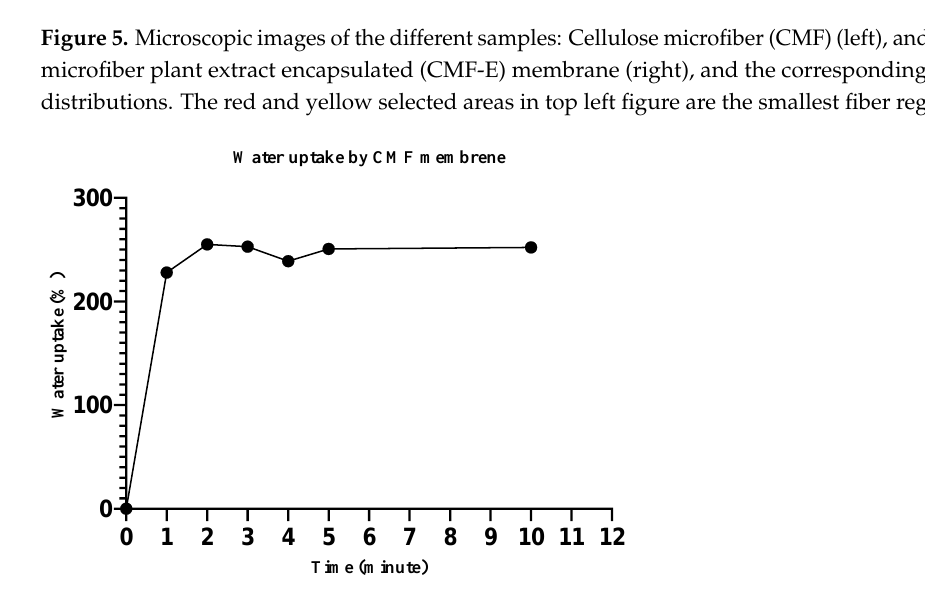
Figure 6. Water uptake efficiency by the cellulose microfiber (CMF) membrane.